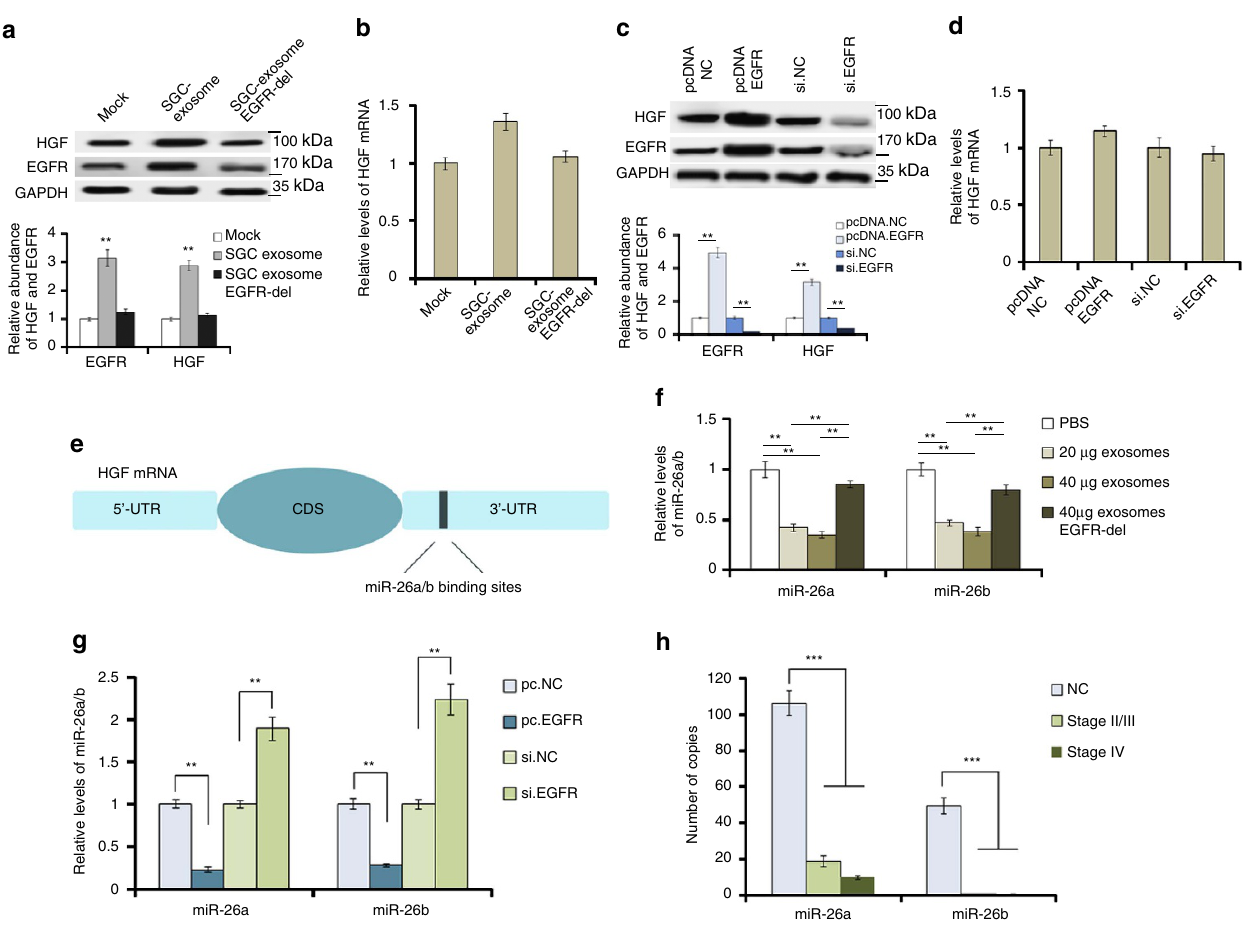
Figure 4 | SGC-exosomes-mediated EGFR activates liver HGF by suppressing miR-26a/b expression. Forty micrograms of exosomes were used to culture with 1 (cid:2) 10 6 primary liver cells seeded in a six-well plate. ( a , b ) Effects of SGC exosomes delivered EGFR on HGF protein levels ( a ) and mRNA levels ( b ) in mixed primary liver cells ( n ¼ 3). ( c , d ) Effects of EGFR on the expression of HGF protein ( c ) and mRNA ( d ) ( n ¼ 3). ( e ) The binding sites of miR-26a/b in the 3 0 -UTR of HGF mRNA. ( f ) SGC-exosomes decrease liver miR-26a/b levels ( n ¼ 3). ( g ) EGFR is negatively related with miR-26a/b in liver cells ( n ¼ 3). ( h ) Absolute quantification of serum miR-26a/b in the progression of GC ( n ¼ 150). The data represent the mean ± s.e.m. ** P o 0.01, *** P o 0.001 (Student’s t